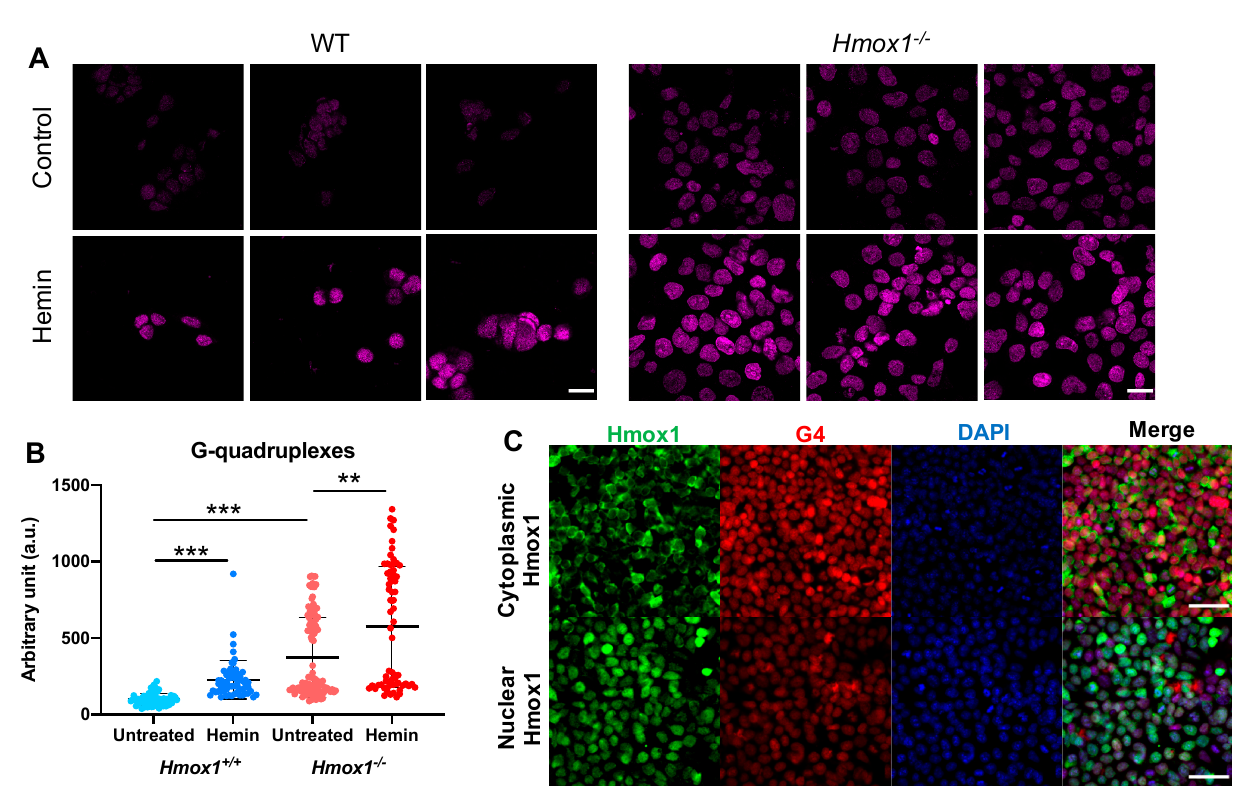
Figure 3. G-quadruplexes in iPSCs. ( A ) G4-specific staining (magenta) of Hmox1 +/+ or Hmox1 − / − iPSCs that were untreated (control) or treated with hemin (2 μ mol/L, 4 h) and ( B ) quantitative analysis of the fluorescence intensity. Analysis of cells from three independent experiments, Kruskall–Wallis test, ** p < 0.01, *** p < 0.001. Scale bars: 20 μ m. ( C ) Staining for Hmox1 (green), G-quadruplexes (red), and DAPI (blue) in Hmox1 − / − and Hmox2 − / − iPSCs with re-introduced cytoplasmic or nuclear Hmox1. Scale bars: 50 μ m.